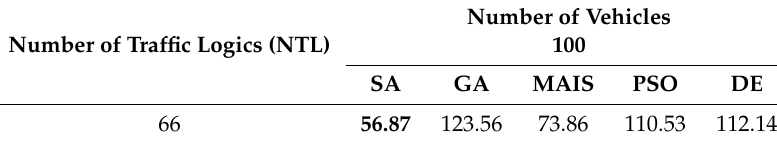
Table 9. Average fitness obtained in